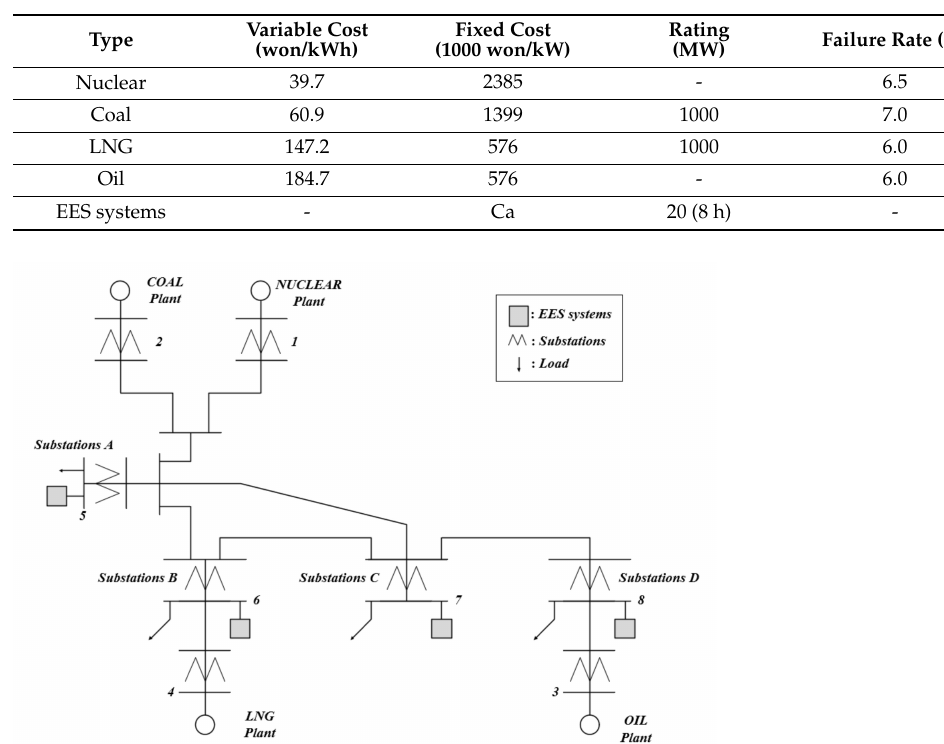
Table 1. Parameters of generation units.